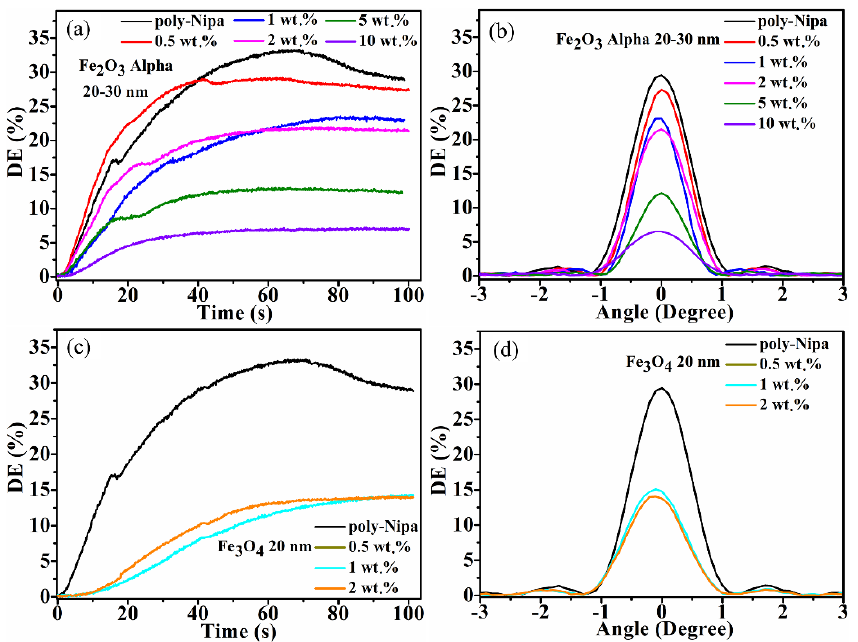
Figure 5. Characterisation of unslanted transmission holographic gratings. ( a , c ) Real-time growth curves and ( b , d ) Bragg selectivity curves. Gratings recorded in pure poly-NIPA photopolymer and nanocomposite doped with 0.5, 1, 2, 5, 10% wt./wt. MNPs Fe 2 O 3 Alpha (average size 20–30 nm) ( a , b ) and gratings recorded in nanocomposite doped with 0.5, 1, 2% wt./wt. MNPs Fe 3 O 4 (average size − 20 nm) ( c , d ). The recording intensity was 6.5 mW/cm 2 and layer thickness 90 ± 8 µ m. Effect of Nanoparticle Concentration in Layers Doped with Fe 3 O 4 with Average Size of 20 nm